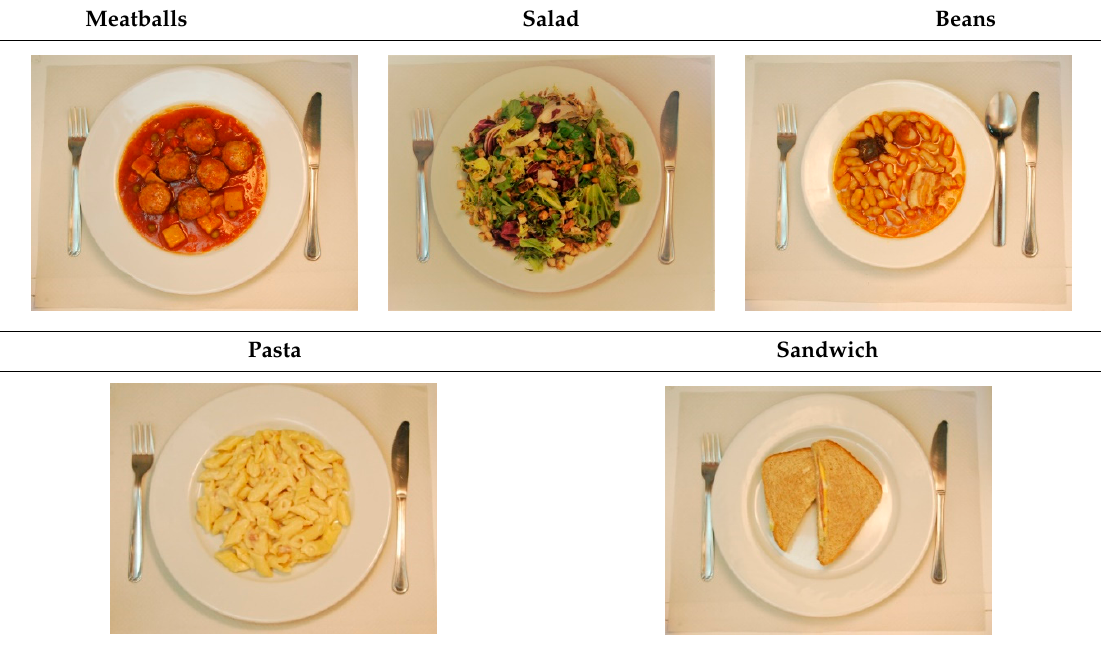
Figure 1. Scheme of the experimental procedure where three different sets of consumers participated in one of the three different conditions and evaluated five meals. Table 2. Photographs of the ready-to-eat meals presented to the participants (Meal-photo condition).